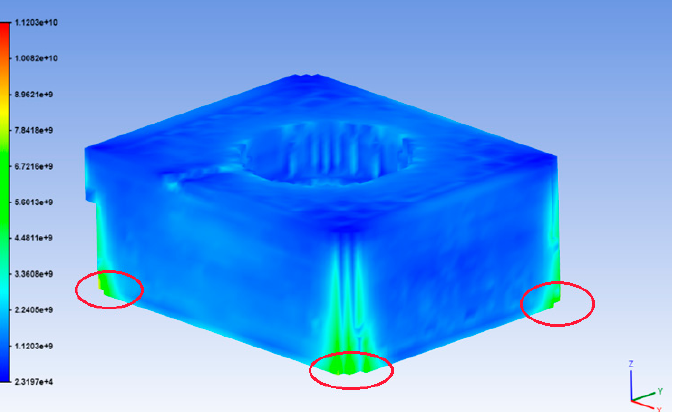
Figure 9. Maximum action of stress in the case of the alternative with the topology elements in the shape of the star .